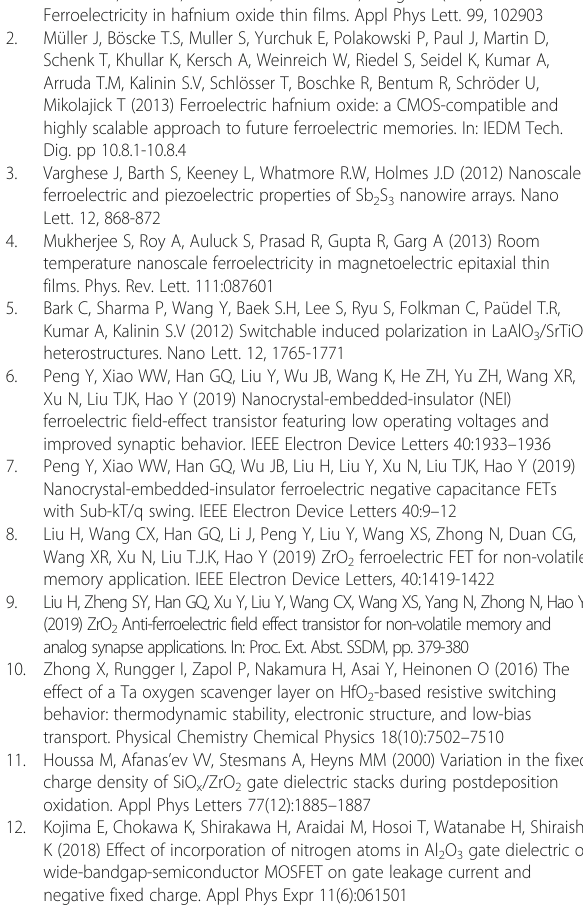
Fig. 9 a The evolution of I DS - V GS curves for the two polarization states for the 2.5, 4, and 9 nm-thick ZrO 2 FeFETs underwent a RTA at 500 °C. b The 4 nm ZrO 2 device has an improved retention performance compared to the transistors with 2.5 and 9 nm-thick ZrO improved fatigue and retention characteristics are ob- tained in the 4 nm-thick ZrO FeFET in comparison with 2 the devices with 2.5 nm and 9 nm ZrO . The retention test 2 indicates that the 4 nm ZrO transistor keeps an extrapo- 2 lated 10-year MW of ~ 0.46 V.